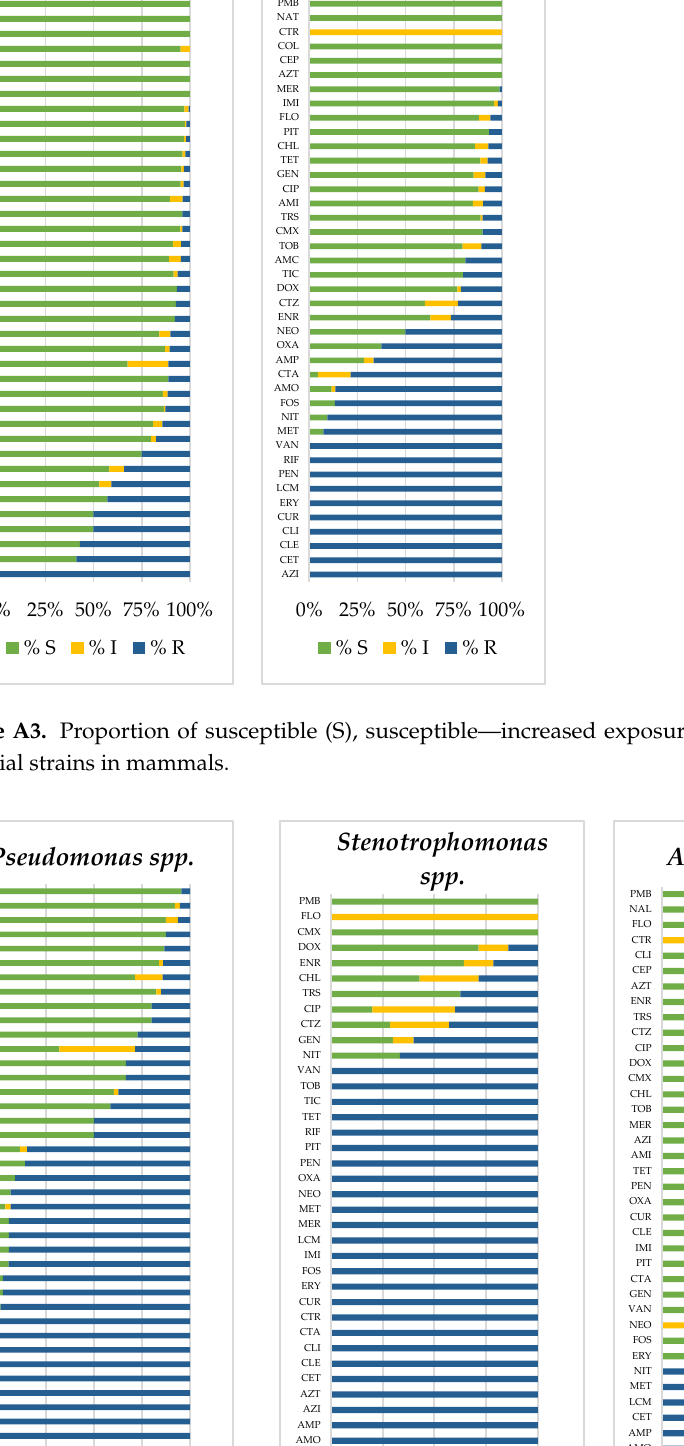
Pasteurella spp.